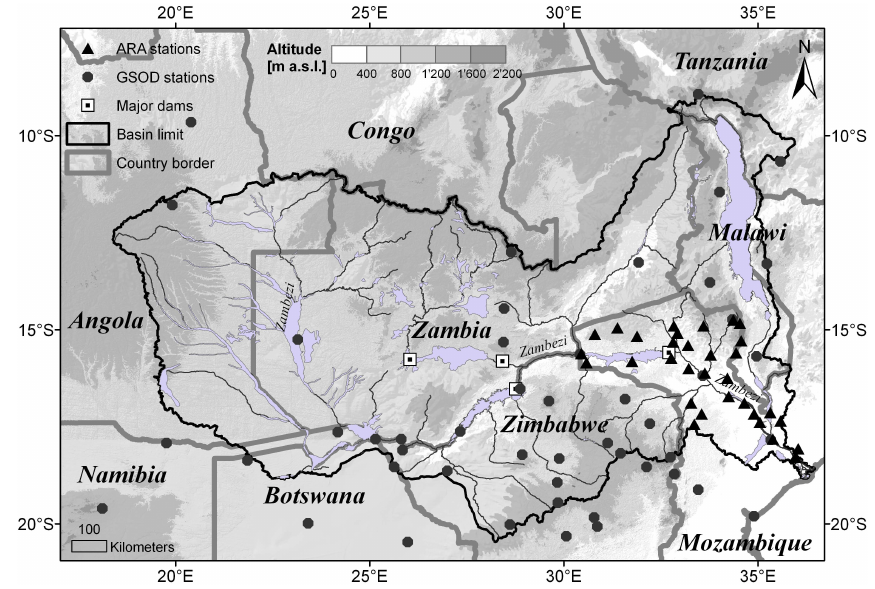
Fig. 1. Map of the Zambezi River Basin showing countries borders, main river network with lakes and flats, major dams and gauges with available rainfall observations for the period 1998 to